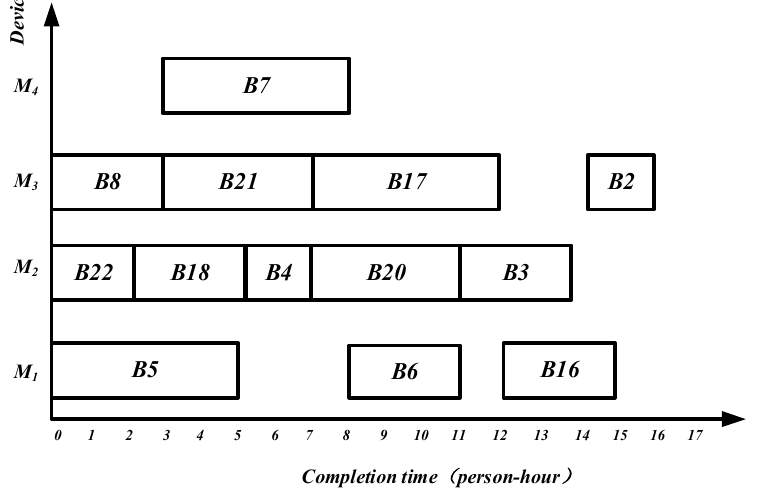
with 11 person ‐ hours. 2